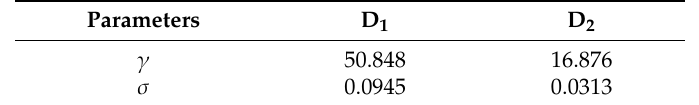
Table 4. Optimal parameters of the forecasting model for M subsample sets and one squared residual